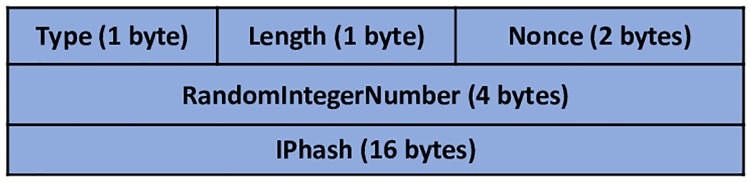
DADmatch option format.